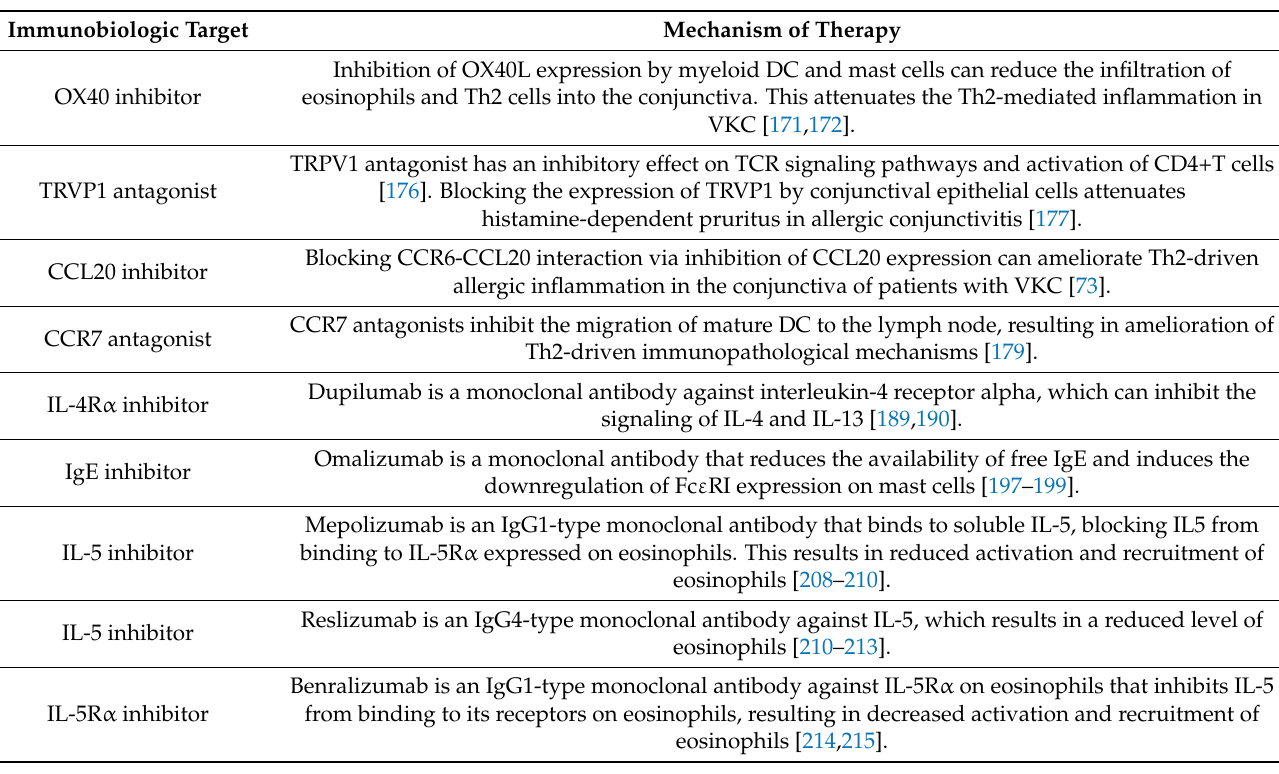
Table 2. Cont. Mechanism of